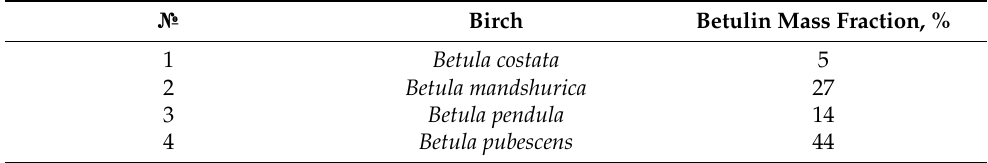
Table 1. Betulin dependence on the birch type.